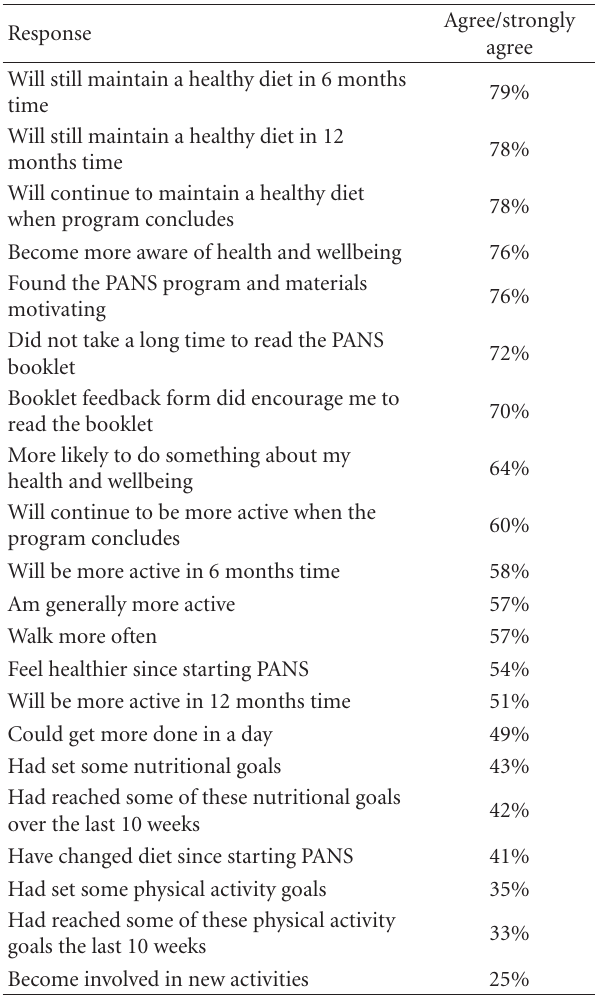
Table 4: Results of exit survey of PANS participants.